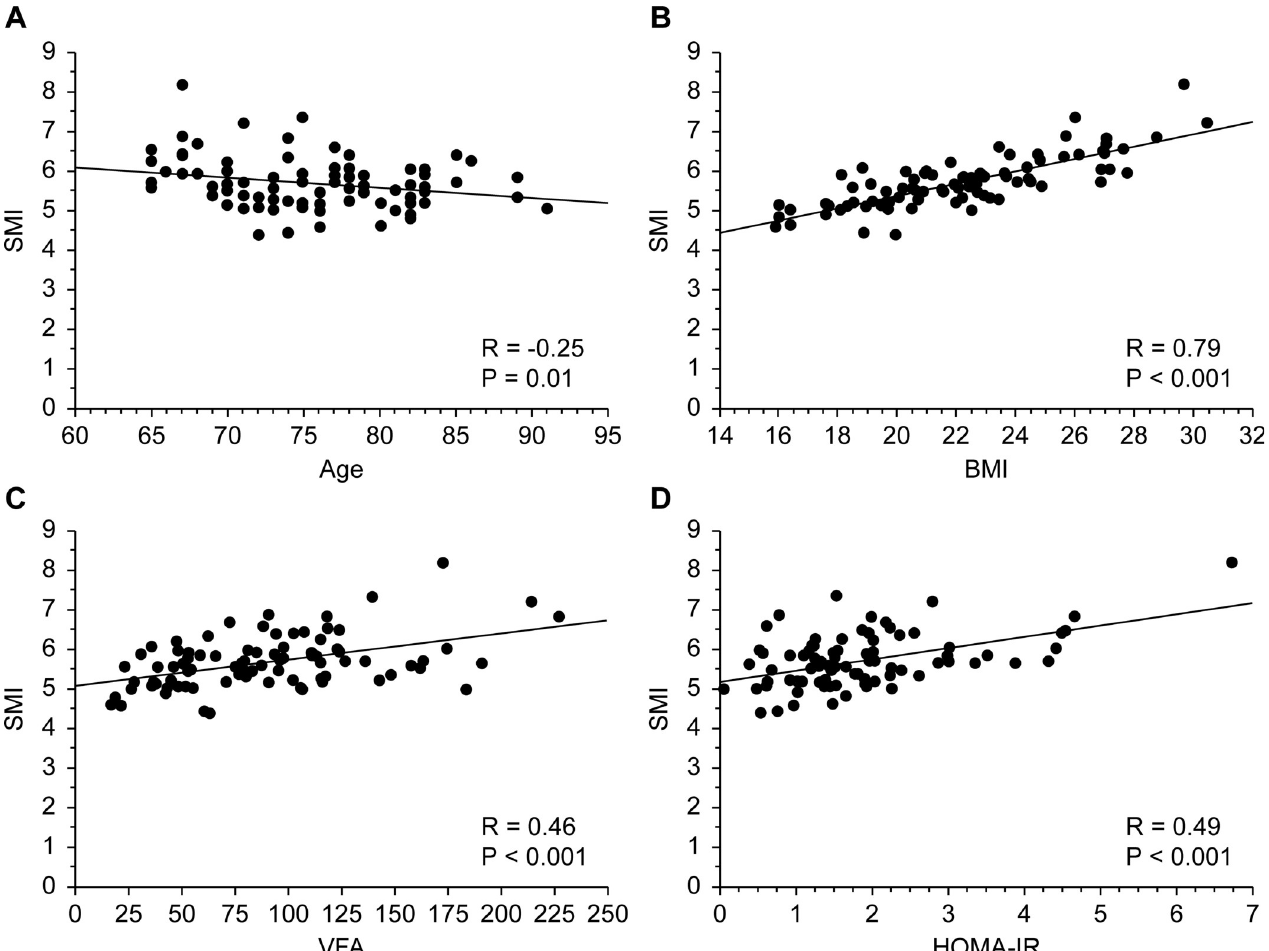
Fig 1. The correlation between SMI (corrected for body size) and age (A) or BMI (B) or VFA (C) or HOMA-IR (D) .